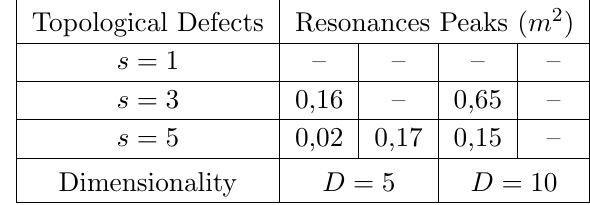
Table 4 . Peaks of resonances for massive right handed